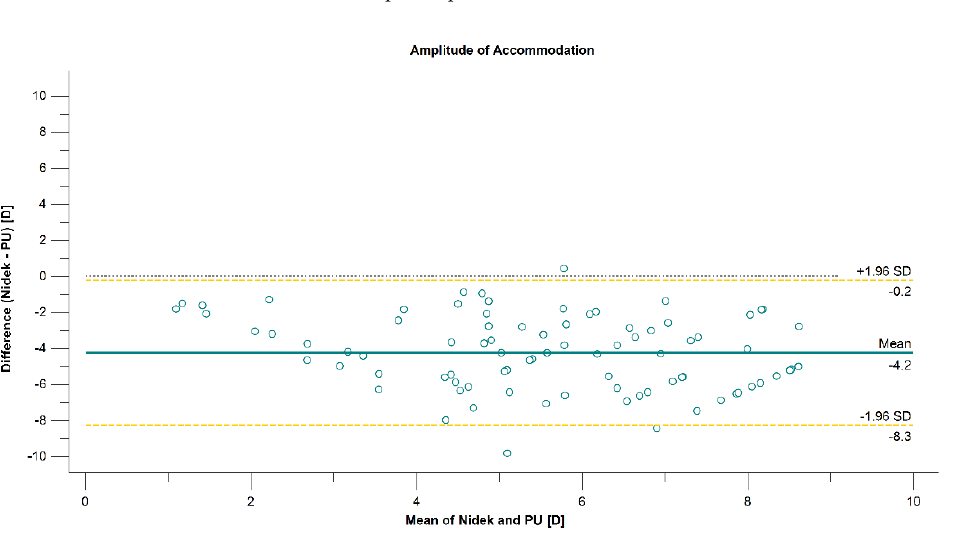
Figure 3. Agreement in amplitude-of-accommodation measurements between the Nidek autorefractor and the push-up (PU) method associated with a 95% CI for difference.